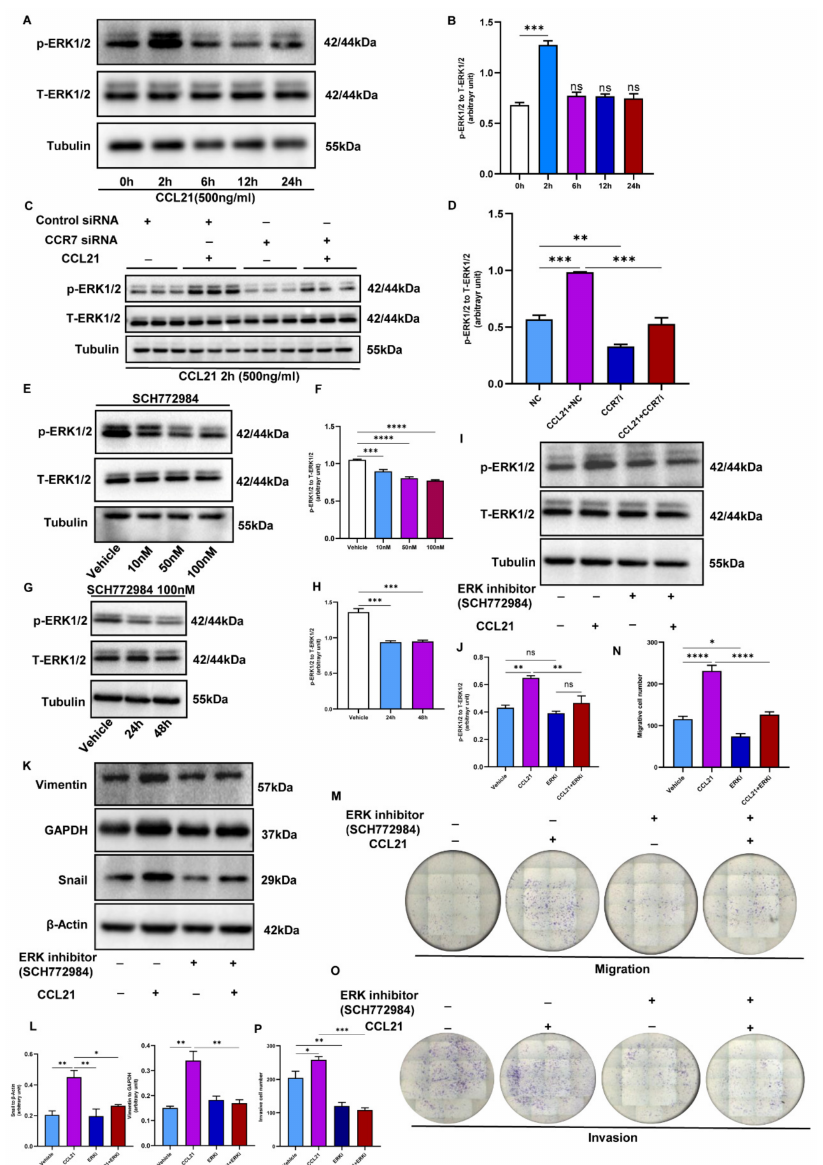
Figure 7. CCL21/CCR7 activates the ERK1/2 signaling pathway to promote the EMT process, mi- gration, and invasion of trophoblast cells. The HTR8/SVneo cells were pretreated with SCH772984 (an ERK1/2 inhibitor) before exposure to rhCCL21. ( A , B ) Western blotting analysis revealed the activation of the ERK1/2 pathway in HTR8/SVneo cells stimulated by rhCCL21 for 2 h, 6 h, 12 h, and 24 h (Supplementary File S1). ( C , D ) Western blotting analysis showed a blocking effect of the ERK1/2 pathway in CCR7-knockdown HTR8/SVneo cells (Supplementary File S1). ( E , F ) ERK1/2 phosphorylation in HTR8/SVneo cells in response to various doses (10–100 nM) of SCH772984 as detected by Western blotting (Supplementary File S1). ( G , H ) The phosphorylation of ERK1/2 in HTR8/SVneo cells in response to SCH772984 (100 nM) treatments over a 48h time course. ( I , J ) The effects of SCH772984 (100 nM) treatment on phosphorylation ERK1/2 were determined by Western blotting (Supplementary File S1). ( K , L ) Western blotting was used to examine the expression of vimentin and Snail in HTR8/SVneo cells treated with SCHCH772984 for 48 h (Supplementary File S1). ( M , N ) A transwell migration assay was performed to detect the trophoblast migration ability after exposure to SCH772984 for 24 h. ( O , P ) A Matrigel invasion assay was used to examine the trophoblast invasion ability after stimulation with SCH772984 for 24 h; * p < 0.05, ** p < 0.01, *** p < 0.001, **** p < 0.0001, ns,